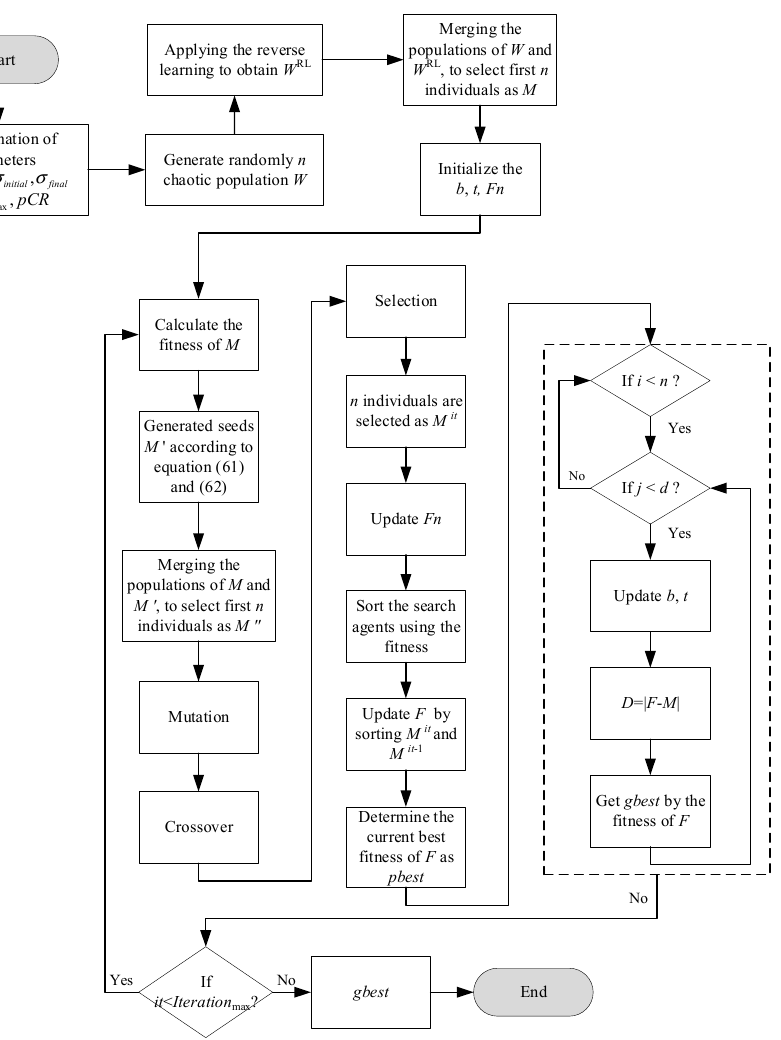
Figure 1. The flowchart of CMF-IWO hybrid algorithm.